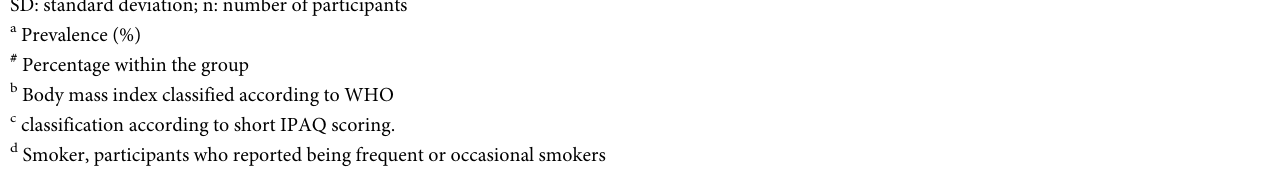
metformin and modifiers (age, physical activity, and BMI) as a continuous variable in the logistic regression to investigate the association between metformin and chronic low back pain for the whole cohort as well as for females and males only. The covariates in the multivariate analyses for the models—physical activity, BMI and age—were retained when the association between the covariate and the outcome (chronic back pain) was less than 0.2 (p-value) in uni- variate models. [28]. Statistical significance was set at p < 0.05, and data analyses were con-